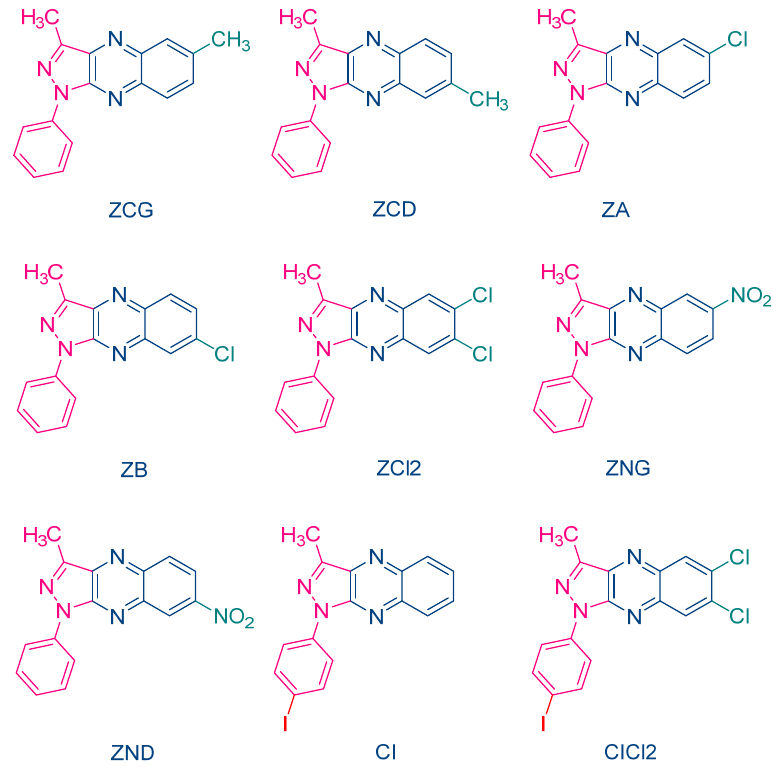
Figure 5. Chemical structures of various pyrazoloquinoxaline dyes. Table 1. Absorption maxima of different quinoxaline dyes in ethyl acetate.